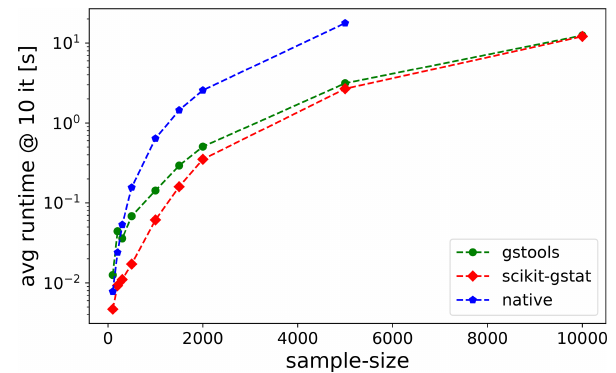
Figure 8. Benchmark test for estimating an experimental vari- ogram. For each sample size, the mean runtime of 10 repetitions is shown. The experimental variogram was calculated with a native Python implementation (blue), gstools (green) and SciKit-GStat